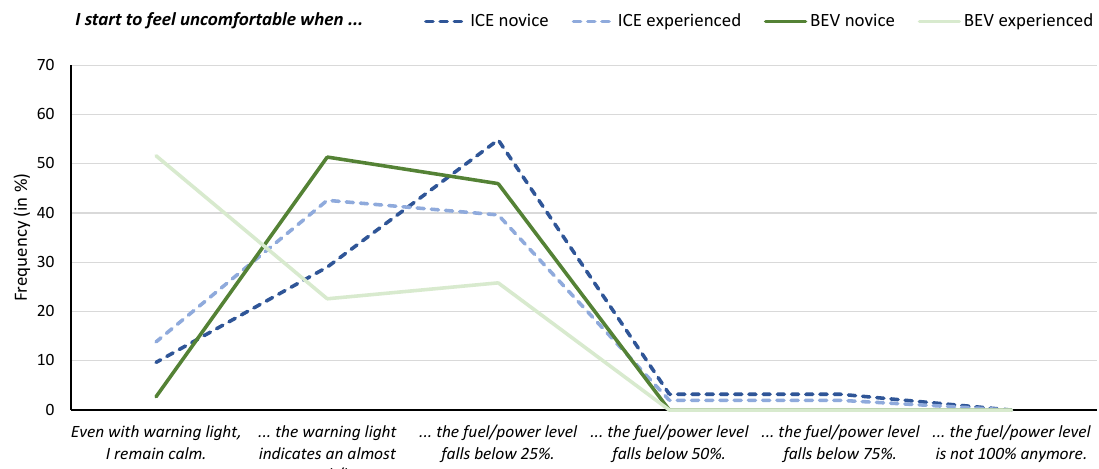
Figure 3. Frequencies of mentioned critical fuel/power levels that cause discomfort among drivers (CRI FIL ), differentiated by experience group.